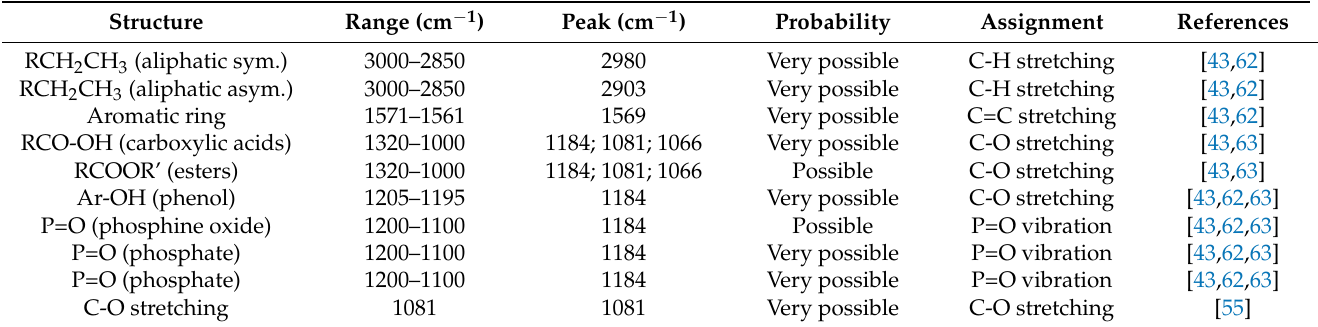
Table 3. Identification of absorption peaks of FTIR spectra for both AC samples.